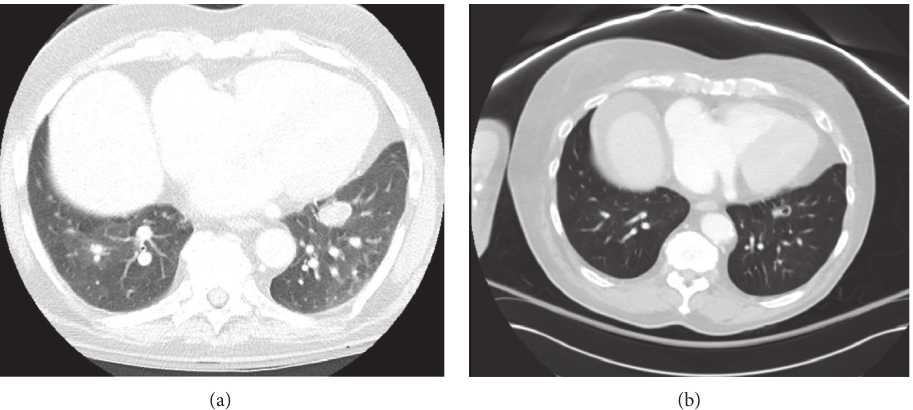
Figure 2: Chest CT. (a) pulmonary nodule on initial presentation; (b) pulmonary nodule on repeat imaging, 3 weeks after initial presentation.